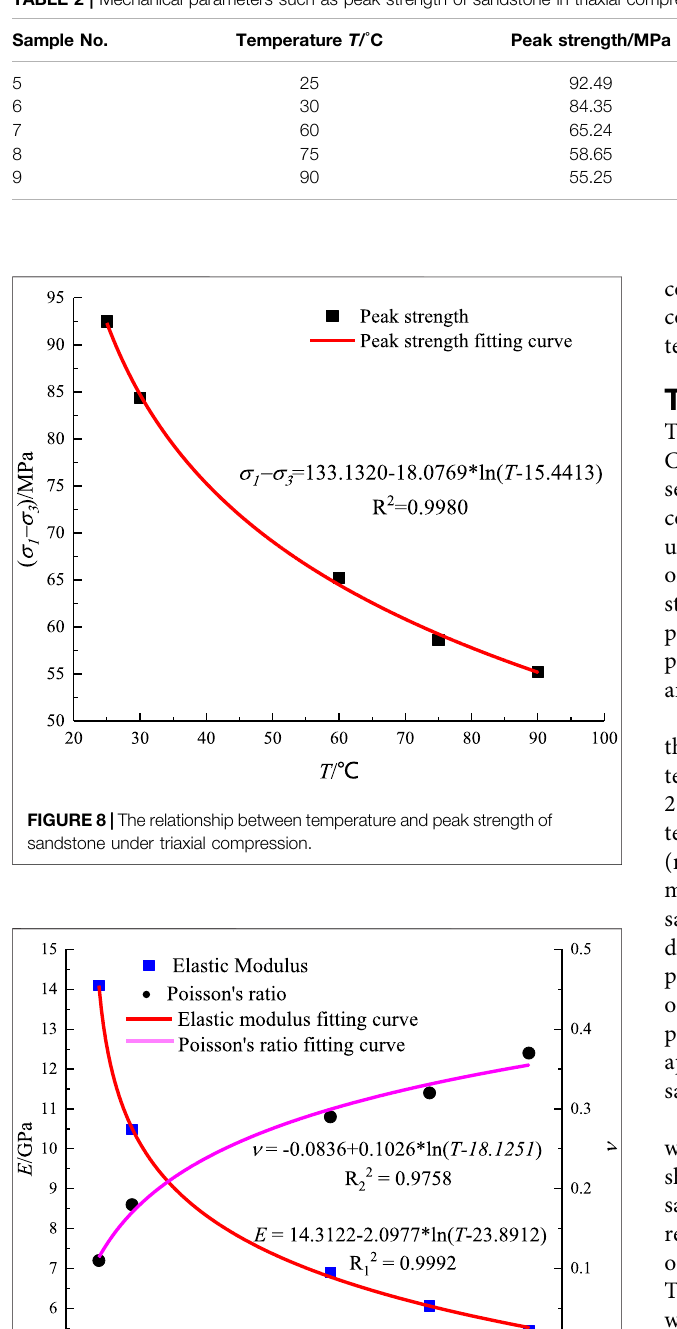
Frontiers in Earth Science |